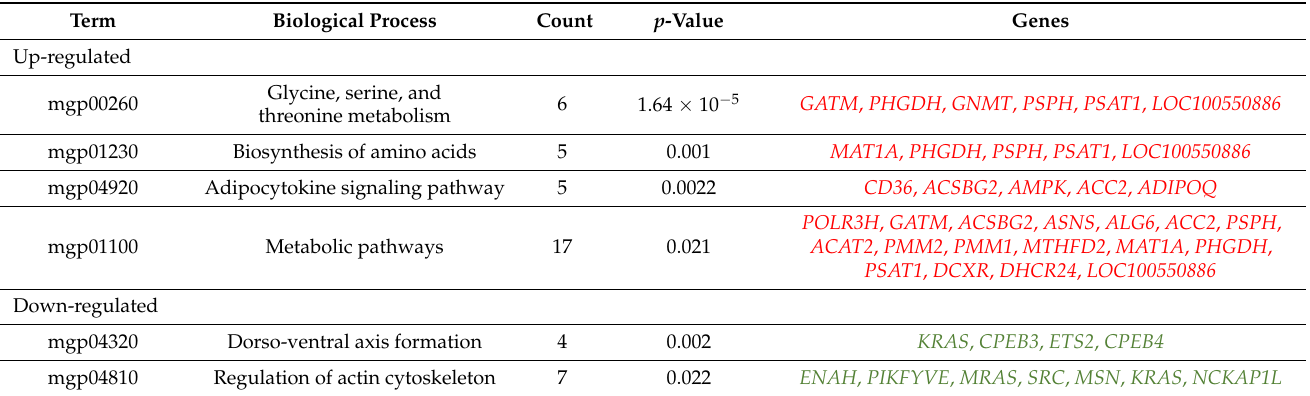
Table 3. Pathway analysis of DEGs in HFE compared to LFE turkeys (genes with red font color represent up-regulated genes, and genes with green font color represent down-regulated